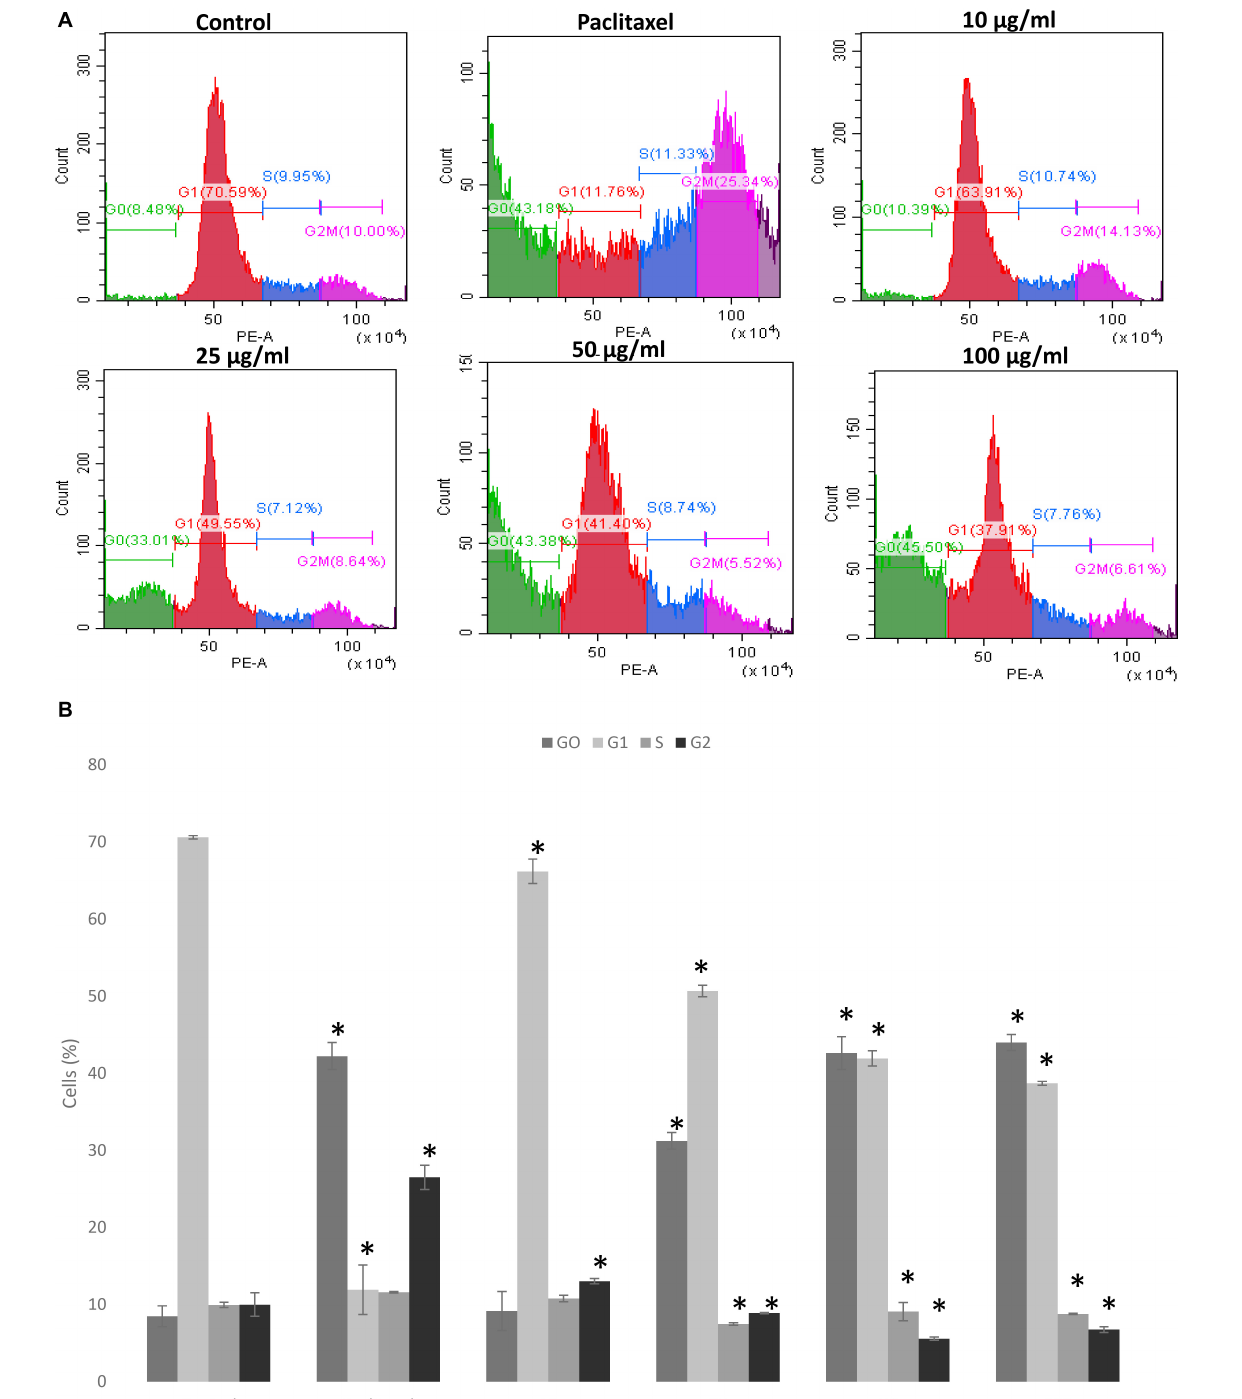
Frontiers in Marine Science |